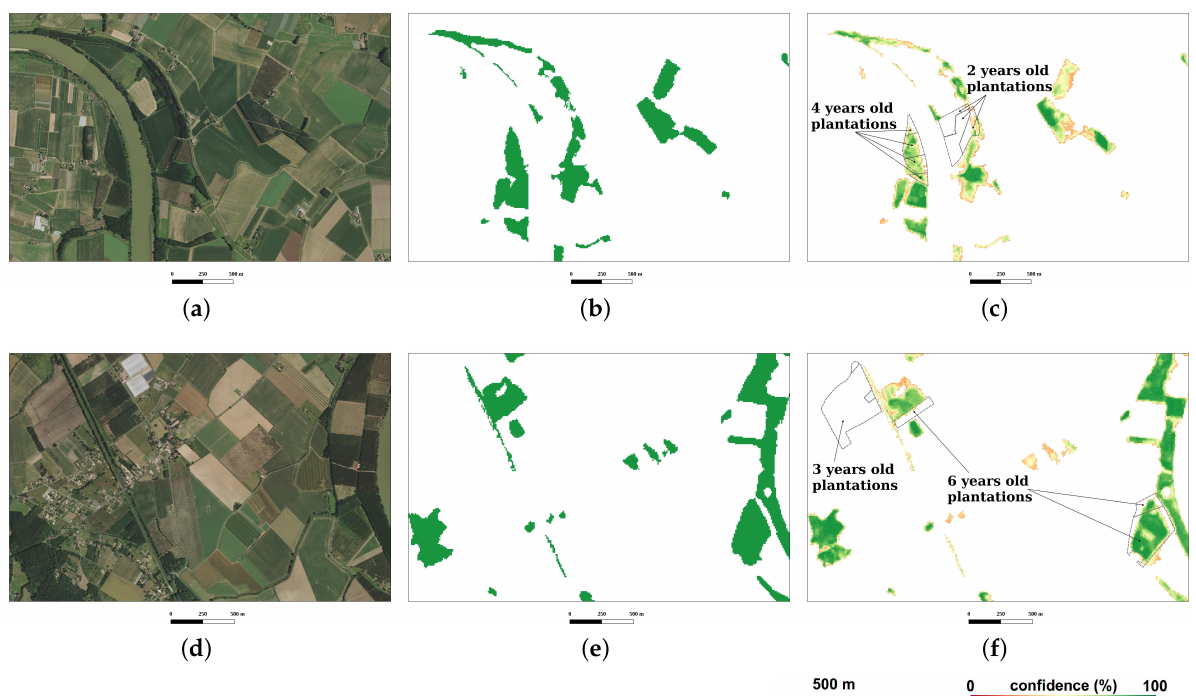
Figure 9. Map extracts located in the Lot-et-Garonne department in tile 30TYQ: ( a , d ) are the 2018 orthophotos, ( b , e ) show the classification results, and ( c , f ) are the confidence maps associated with the red-yellow-green scheme palette (the highest confidence rates are in green).